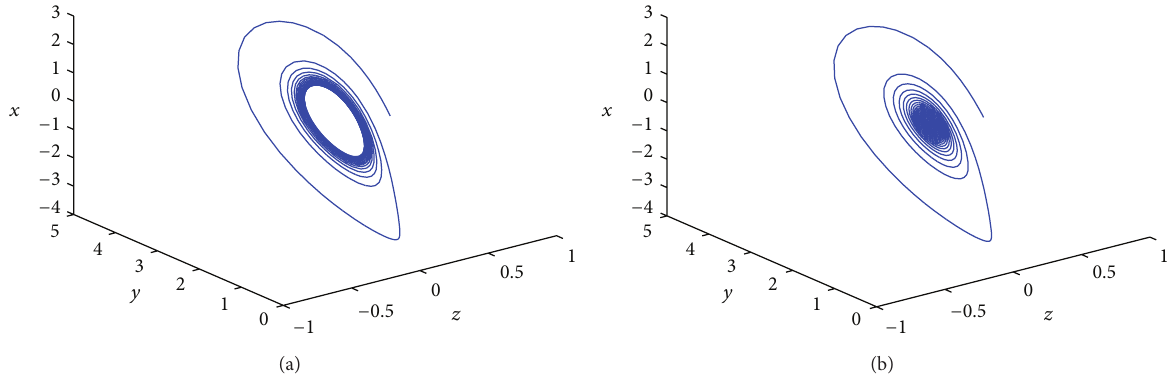
Figure 3: (a) Phase plane of system (1) with parameter 𝐺 = 1.9 . (b) Phase plane of system (1) with parameters 𝐺 = 2.1 .